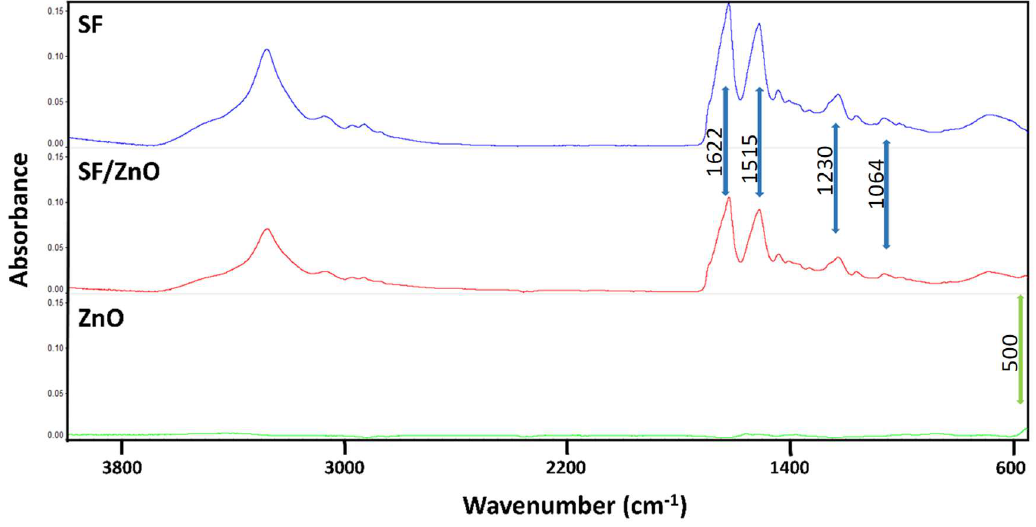
Figure 4. Infrared spectra of pure fibroin electrospun meshes (SF), fibroin mats containing ZnO nanoparticles (SF/ZnO) and pure ZnO nanoparticles (ZnO).